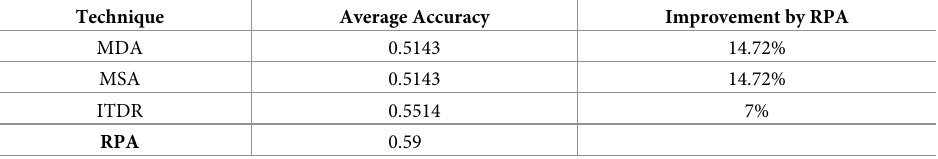
Table 18. Average percentage improvement of accuracy by RPA technique.